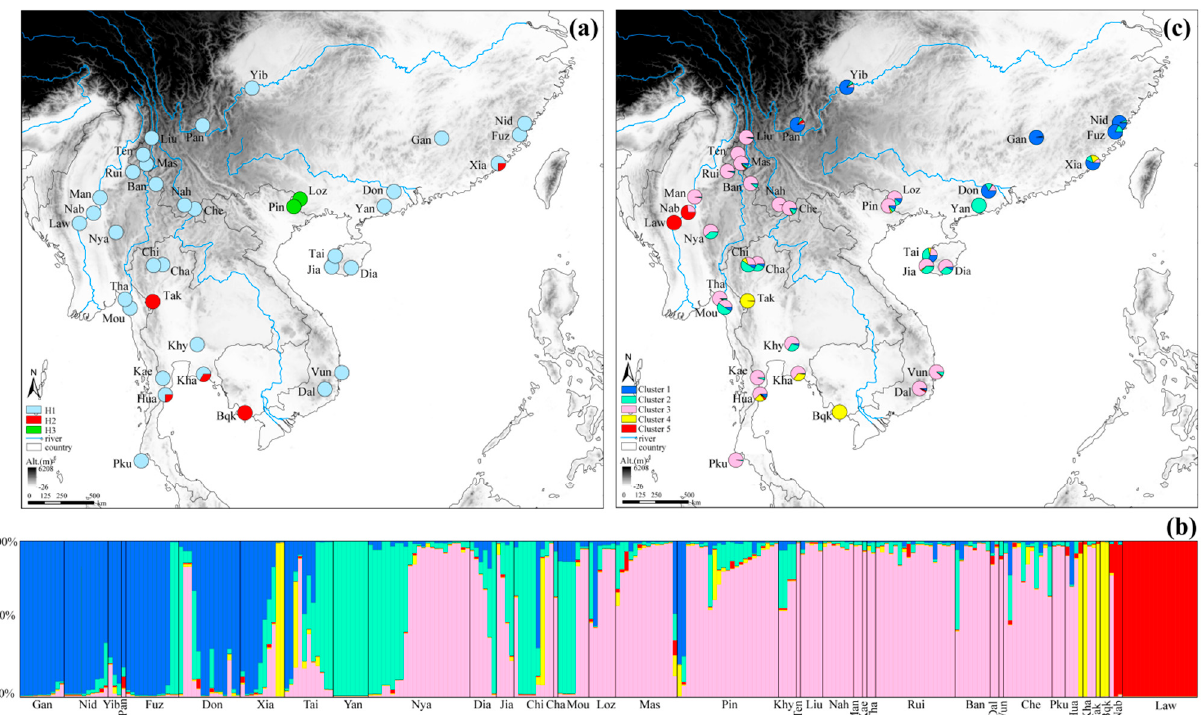
Figure 1. Sample locations and genetic structure of F. altissima in Indo-Burma and adjacent southern China: ( a ) geographical distribution of cpDNA haplotypes; ( b ) bar plots of the membership probabilities of F. altissima individuals to the different clusters from the STRUCTURE analysis at K = 5 based on 16 nSSRs; ( c ) geographical distribution of the genetic clusters detected in STRUCTURE, and the pie charts represent the assignment values of the admixed clustering analysis performed in STRUCTURE for all individuals.